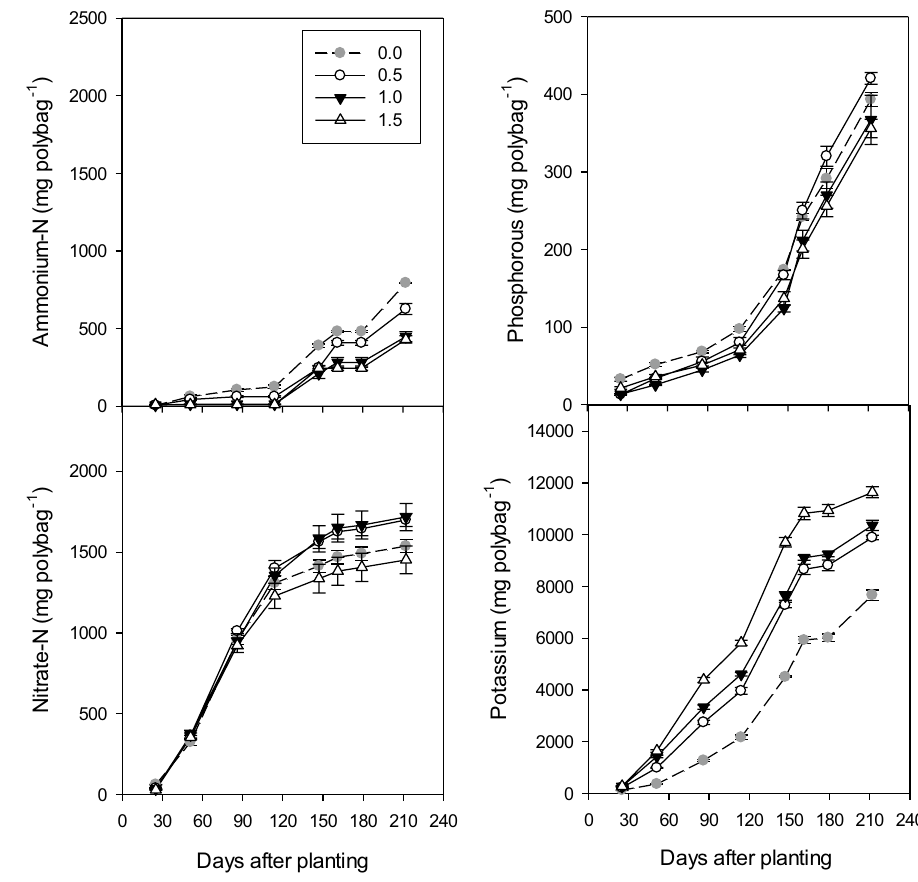
Within each row, means with different letters (small and capital letter) are significantly different at respec- tive compost rates (0 and 30% v/v, respectively) at P ≤ 0.05 according to LSD Fig. 6 Effects of biochar (0, 0.5, 1.0 and 1.5% C addition) application rates on cumulative leaching of NH 4+ -N, NO 3− -N, PO 4−3 , and K + (mean ± standard error) throughout the study period. ( n =